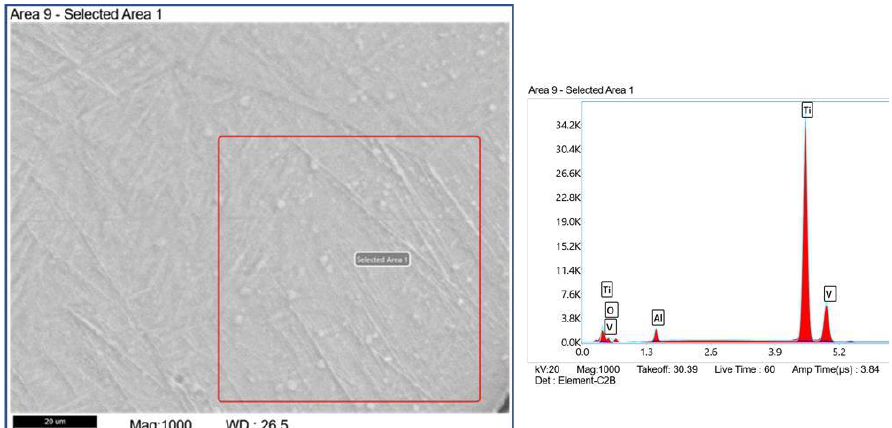
Figure 5. The EDS analysis in the edge area of the single-bead samples. Table 3. The element composition of single-bead samples.